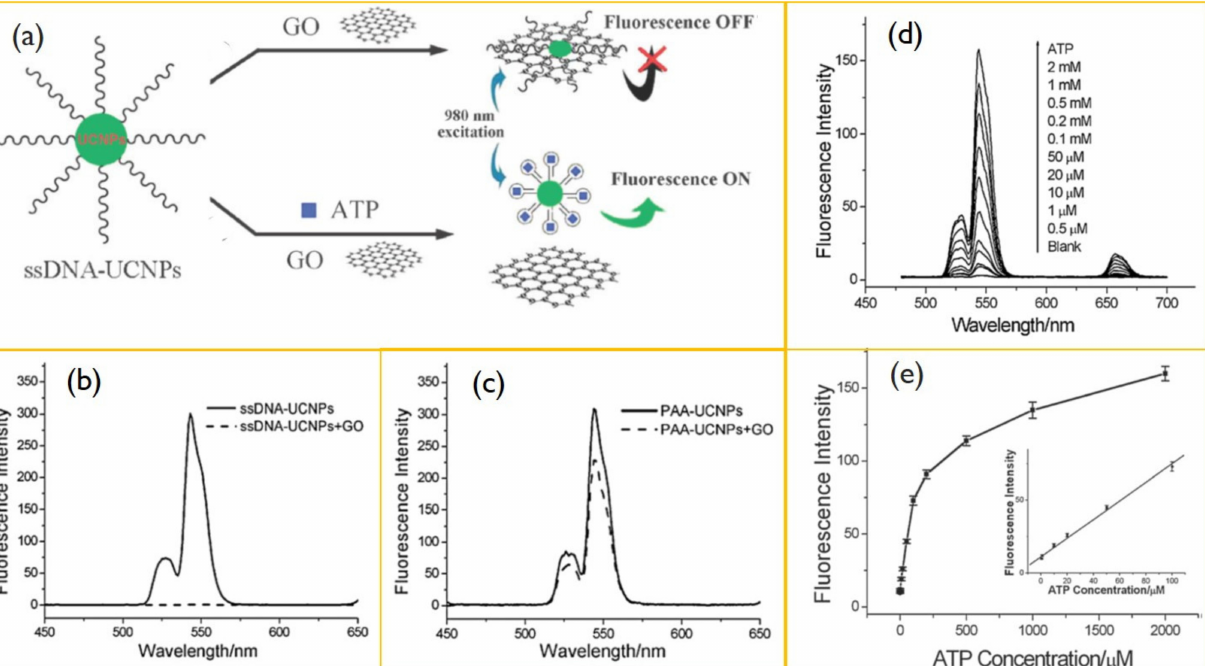
Figure 8. ( a ) Schematic illustration of ATP sensing using a resonance energy transfer between ssDNA-UCNPs. ( b ) Up- conversion spectra of ssDNA-UCNPs in Tris-HCl buffer after (dashed line) and before (solid line) incubation with GO. ( c ) Upconversion emission of PAA-UCNPs in Tris-HCl buffer after (dashed line) and before (solid line) the addition of GO. ( d ) Upconversion spectra of UCNPs-GO in the presence of 0–2 mM ATP. ( e ) Plot of upconversion emission intensity (at 547 nm) vs. ATP concentration. Reproduced with permission from